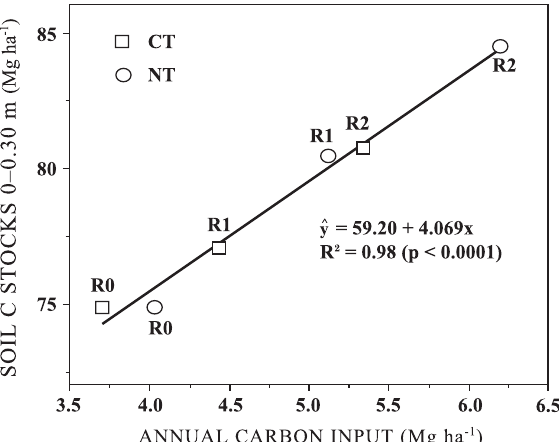
Figure 3. Relationship between annual carbon input and soil organic stocks (0–0.30m) of a subtropical Oxisol under conventional (CT) and no-tillage (NT) systems under three crop rotations (R0=wheat/soybean; R1=wheat/ soybean/black oat/soybean; R2=black oat/ soybean / black oat+common vetch/maize/oilseed